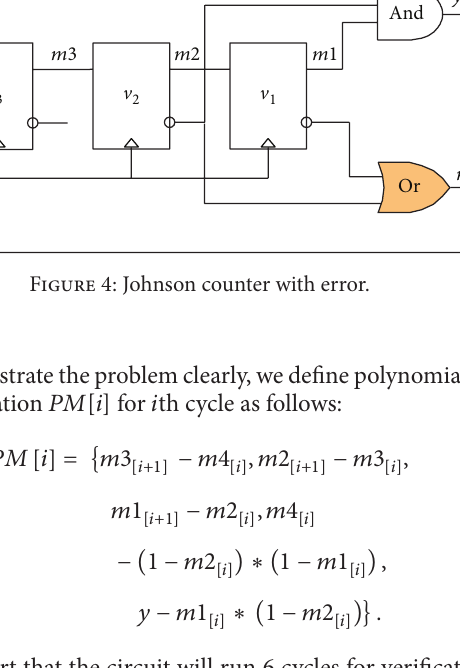
Table 4: Polynomial